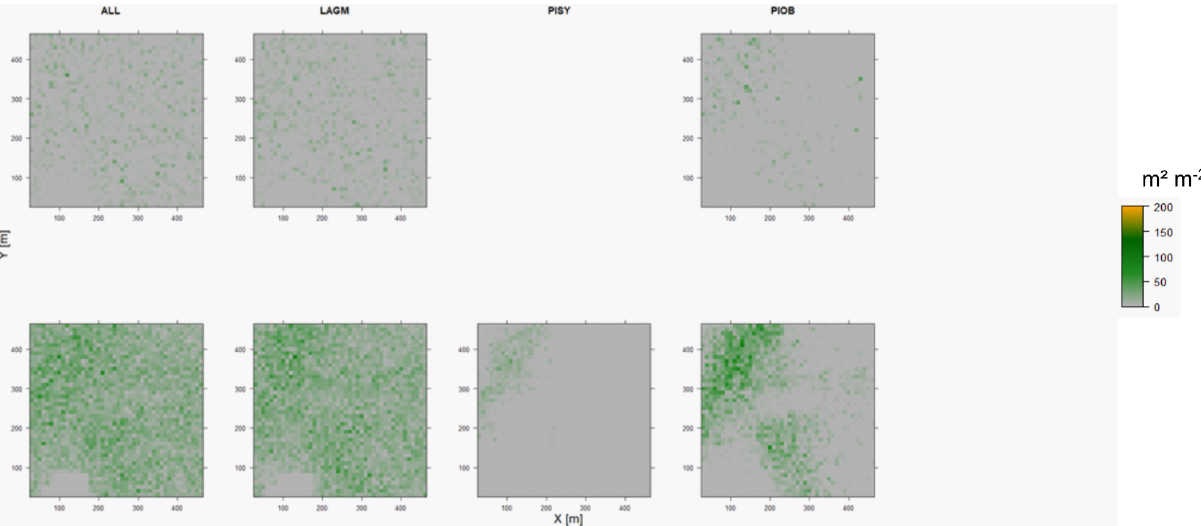
Figure D8. Leaf area index (LAI) values of the CryoGrid grid aggregated at year 2030 at Nyurba. Upper row shows LAVESI–CryoGrid coupled; lower row shows LAVESI simulations. LAGM: Larix gmelinii ; PIOB: Picea obovata ; PISI: Pinus sibirica ; PISY: Pinus sylvestris . Simulations with PISI and PISY coupled were not